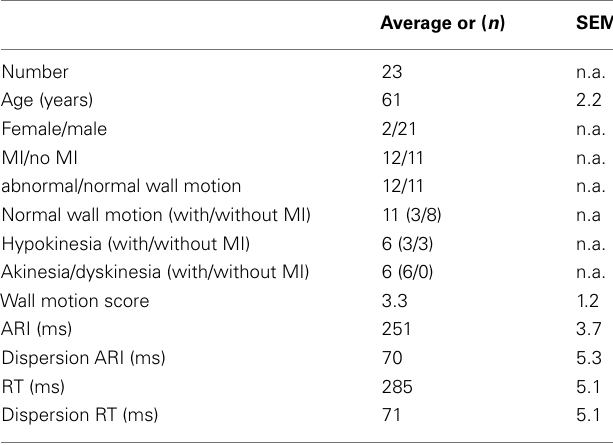
Table 1 | Data in the whole patient group ( n =